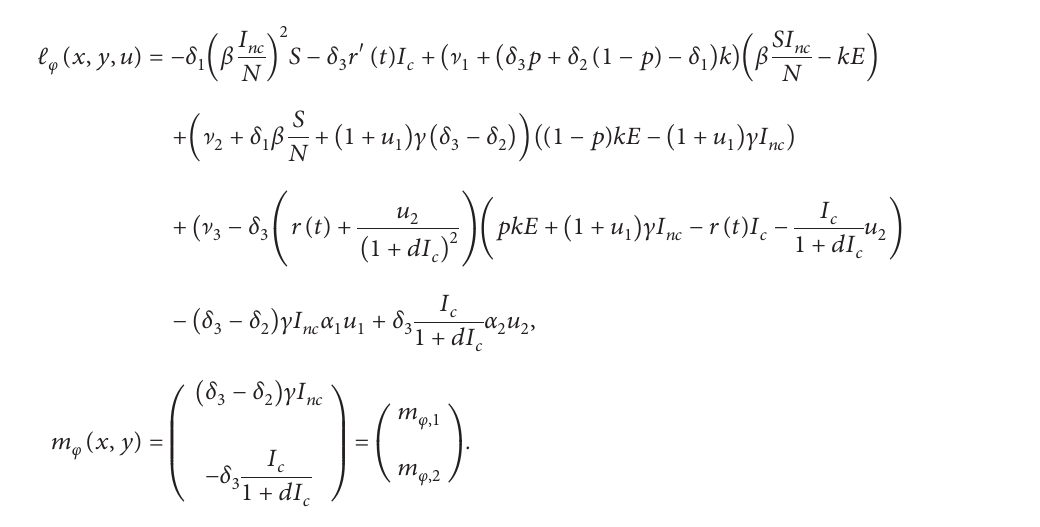
I u and u are applied and without control. (a) Exposed individuals E . (b) Undiagnosed nc , and c when both controls 1 2 � u max � 0 . 1 2